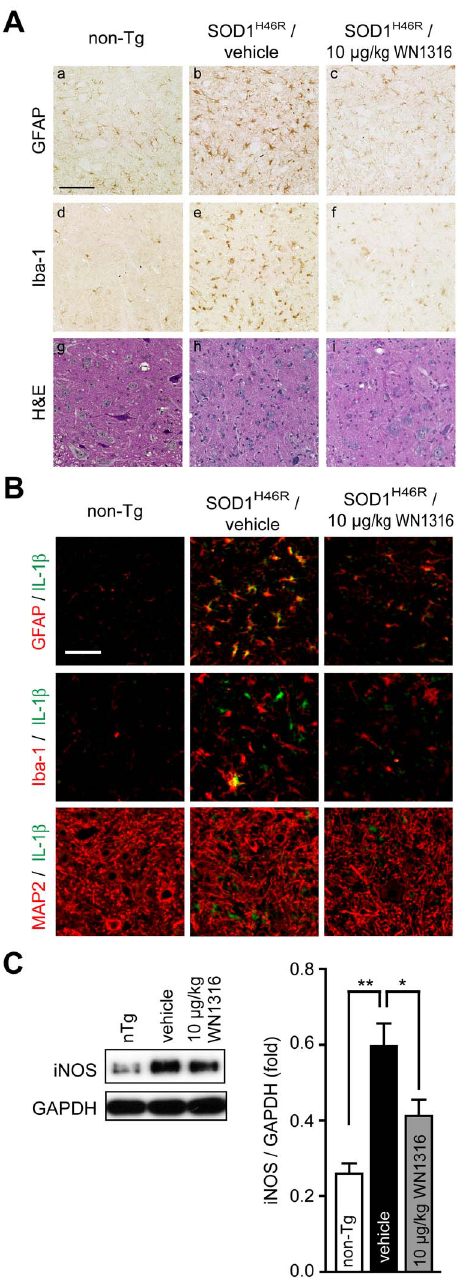
Figure 6. The WN1316 treatment suppresses astrocytic and microglial activation and reduces the level of IL-1 b and iNOS in the spinal cord. (A) Immunohistochemical analysis of paraffin embedded sections of the lumbar spinal cord from non-Tg (a, d, and g), vehicle-treated ALS(SOD1 H46R ) (b, e, and h), and 10 m g/kg WN1316- treated ALS(SOD1 H46R ) (c, f, and i) mice at 21–22 weeks of age (late symptomatic stage). Representative images of immunostaining with GFAP (a, b, and c) and Iba-1 (d, e, and f) and histochemical staining with hematoxylin-eosin (H&E) (g, h, and i) are shown. Scale bar indicates 100 m m. (B) Immunohistochemical analysis of frozen sections of the lumbar spinal cord from non-Tg, vehicle-treated ALS(SOD1 H46R ), and 10 m g/kg WN1316-treated ALS(SOD1 H46R ) mice at 21–22 weeks of age (late symptomatic stage). Representative merged images of double immunostaining with IL-1 b (green) and GFAP (for astrocytes) (red), Iba-1 (for microglia) (red), or microtubule-associated protein 2 (MAP2) (for neurons) (red) are shown. Merged signals are shown in yellow. Scale